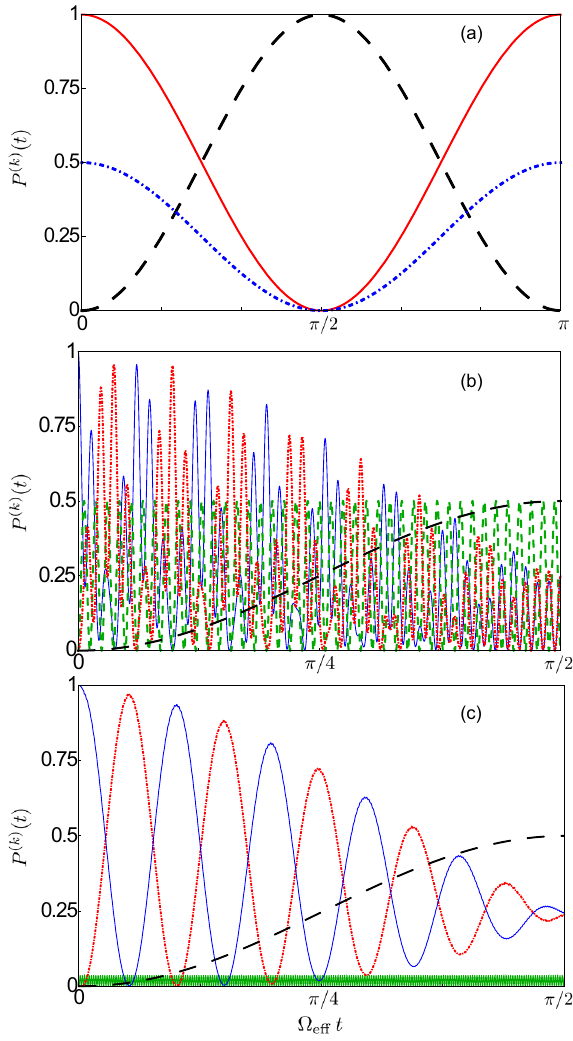
P P Figure 7. ( a ) Time evolution of the occupation probabilities P ( k ) ( t ) k = | k �� k | , for the one- k � , with ˆ ≡ � ˆ 1 A 1 1 photon states (red solid curve) and (blue dot-dashed curve), together with the probability P ( ee ) ( t ) of | � | � having both qubits simultaneously excited (black dashed curve). Here, the system is initially prepared in the , 1 A , g , g , 0 S 1 A 0 S 0 ). As the times evolves, the one-photon state and in the absence of detuning ( (cid:31) 2 1 � | � ≡ | = excitation is progressively transferred to the two qubits at the same time, until the maximum simultaneous qubit π/( 2 � eff ) . ( b ) Temporal dynamics of the occupation 1 ) by a single photon is reached at t excitation ( P ( ee ) = = probabilities P ( 1 1 ) (blue solid curve), P ( 1 2 ) (green dashed curve) and P ( 1 3 ) (red dot-dashed curve), together with the probability P ( ee ) (black dashed curve) of having both qubits simultaneously excited when the system is ψ 1 0 . ( c ) Temporal dynamics 1 1 initially prepared in the one-photon state of the first resonator with (cid:31) = | � = | � 0.5 of the same occupation probabilities P ( k ) ( t ) considered in ( b ) but in the presence of the detuning �/ω c =